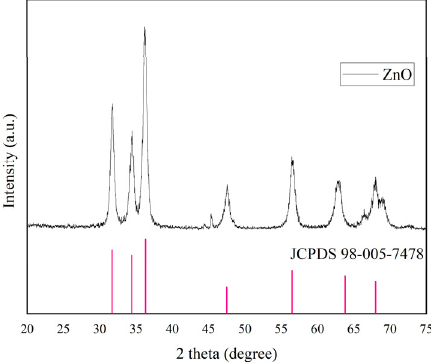
Figure 6. X-ray Diffraction of CuO NPs.